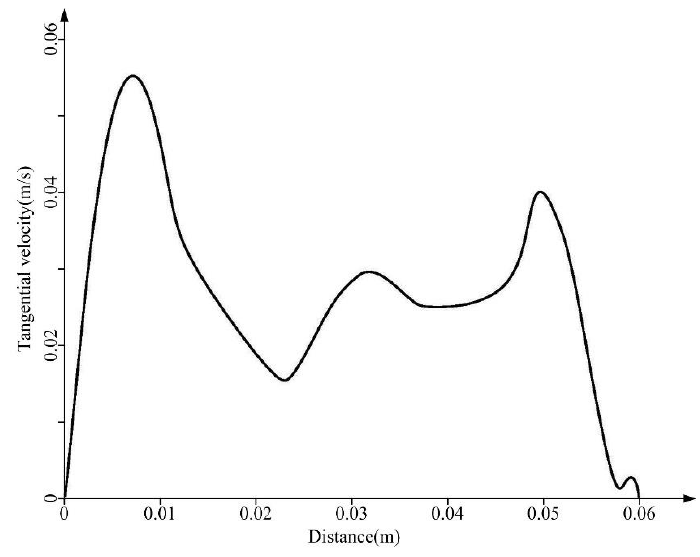
Figure 15. Tangential velocity of particles in the optimized flow passage.